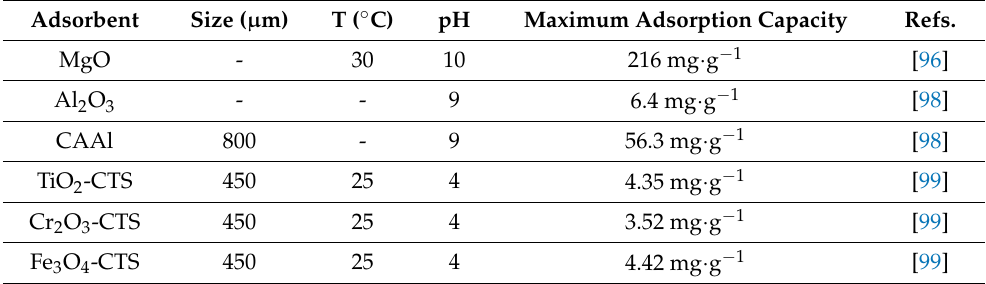
Figure 10. Representative mechanism of boron adsorption on the hydrous surface of metal oxides. Surface group deprotonation: reactions 1 and 6; monodentate complexation: reactions 2 and 4; bidentate complexation: reactions 3 and 5. Reproduced based on [80]. Table 14. Performances of metal oxide-based adsorbents in boron